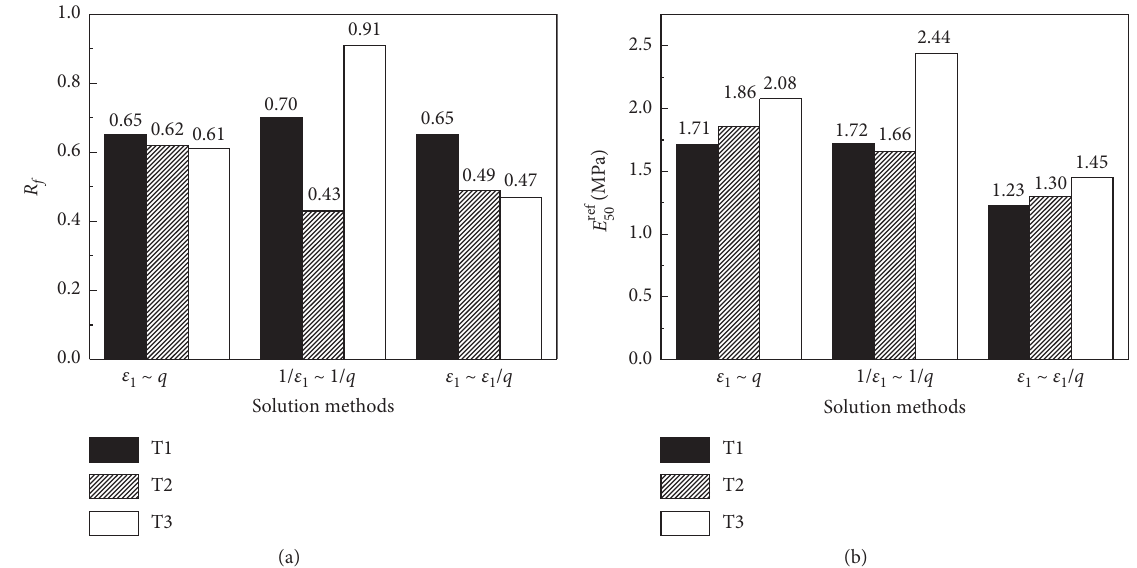
Figure 9: R E ref obtained by using the above three methods. (a) R f contrast. (b) E ref f and 50